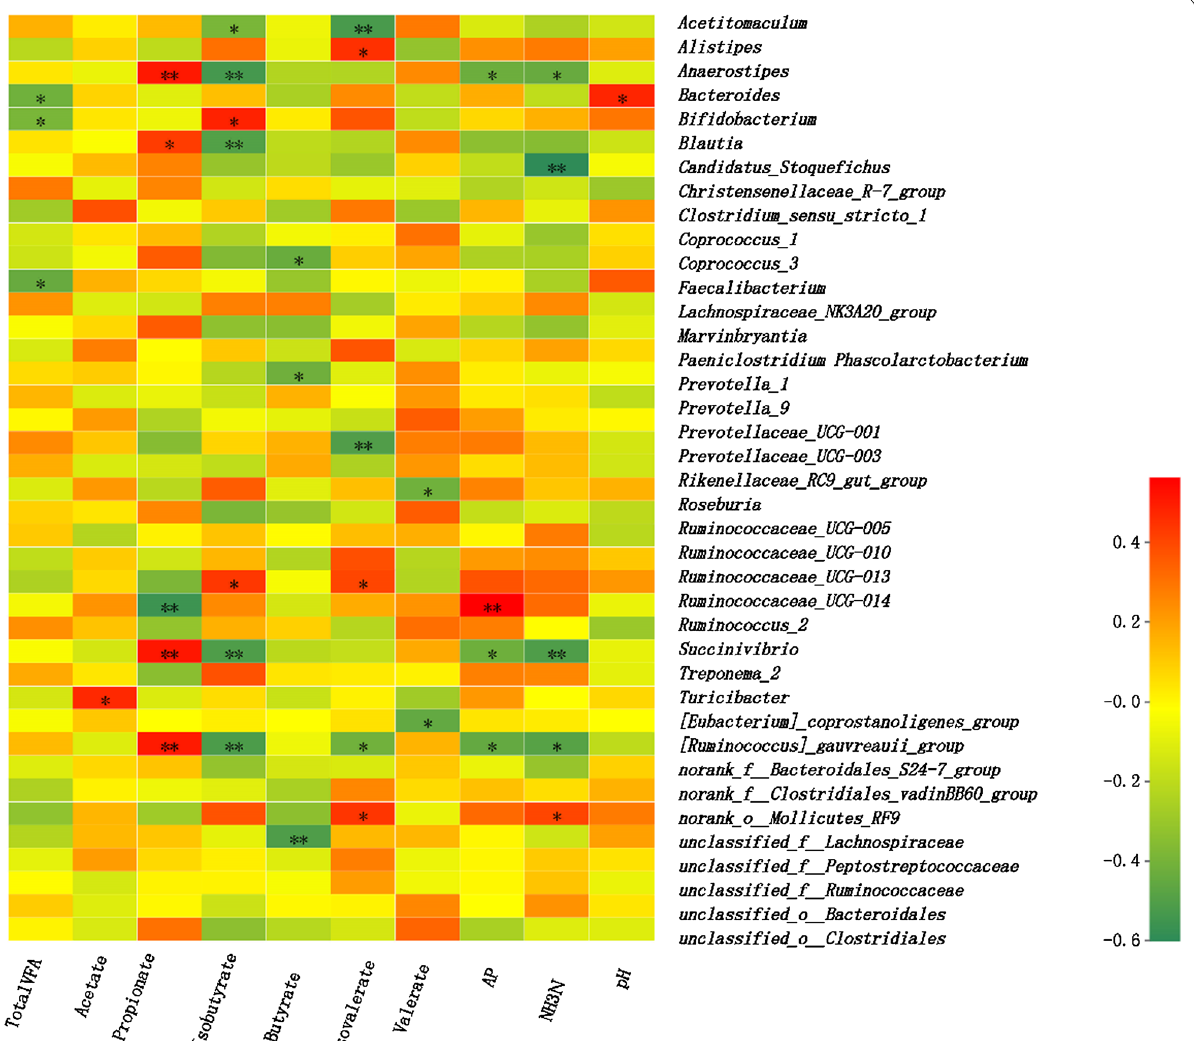
Fig. 4 Correlation between the relative abundances of bacterial genus level and the fermentation characteristics (top 40 genus). Total VFA, total volatile fatty acid; AP, acetate-to-propionate ration; AN, NH 3 -N. * means 0.01 < P